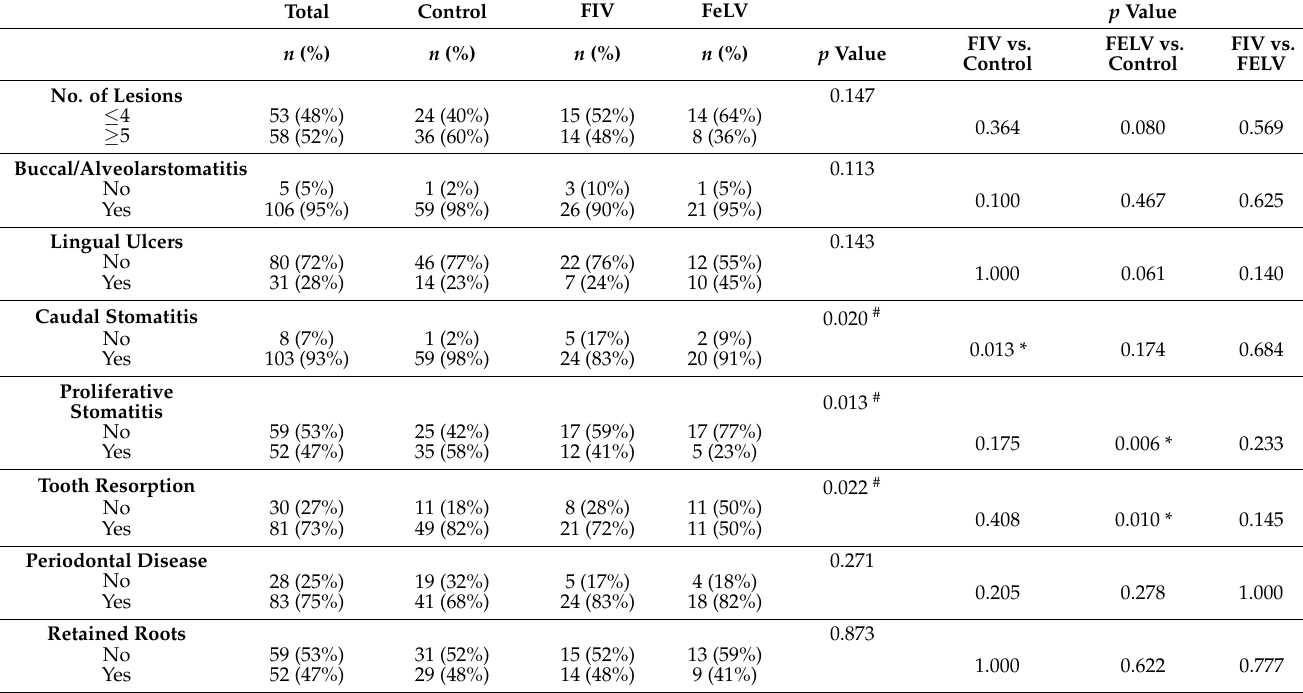
Table 3. Clinical presentation and radiographic findings